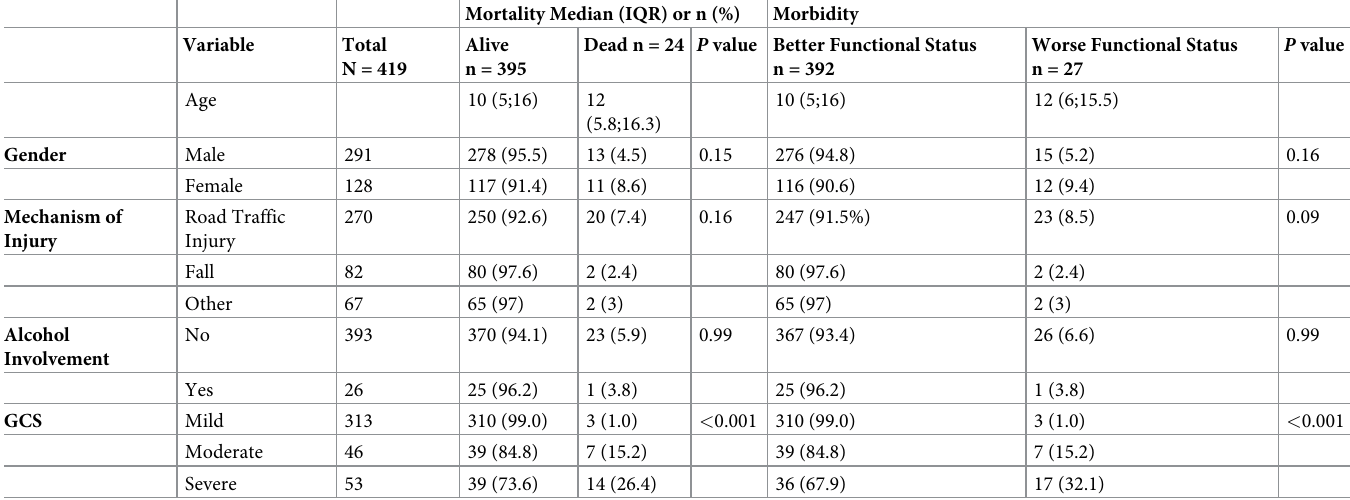
Table 2. Patient and injury characteristics by